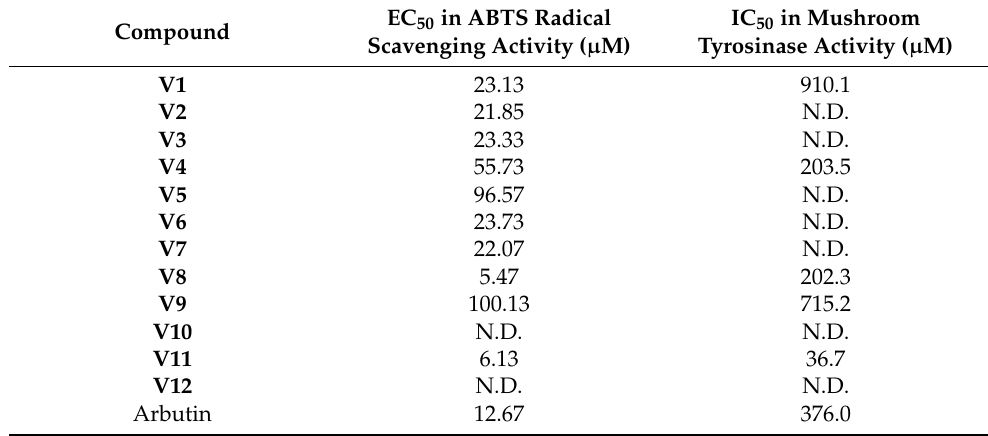
Table 2. Inhibitory effect of velutin derivatives on ABTS radical scavenging and mushroom tyrosi- nase